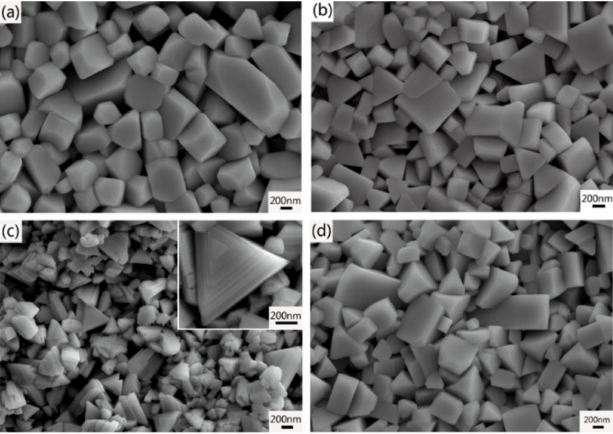
Figure 10. Morphology of WC grains extracted from the WC-10 wt. % Co sintered cemented carbides. ( a ) WC–10Co; ( b ) WC–10Co–0.8Cr 3 C 2 ; ( c ) WC–10Co–0.8VC; ( d )